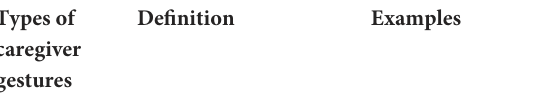
TABLE 2 Caregiver gestures and types of